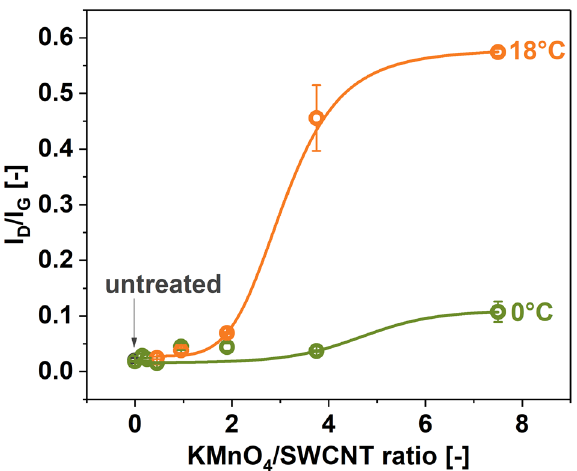
Figure 6. The impact of SWCNT oxidation on the I D /I G ratio of the films made from oxidized SWCNTs determined by Raman spectroscopy as a function of KMnO 4 /SWCNT ratio (t = 0 min).